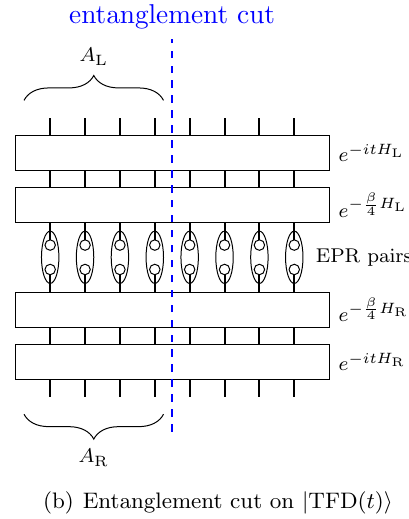
Figure 1 . (a) Illustration of the TFD state, which is obtained by applying imaginary time evolution e (cid:0) (cid:12) 4 H L and e (cid:0) (cid:12) 4 H R to a state j I i of the two-chain system. j I i is a direct product of local EPR pairs between the two sites in the two chains at the same spatial location. (b) The real time evolution of the TFD state by U ( t ) = exp[ (cid:0) it ( H L + H R )] and our choice of entanglement cut. We study the Renyi entropies of the region A = A L [ A R , with support on both